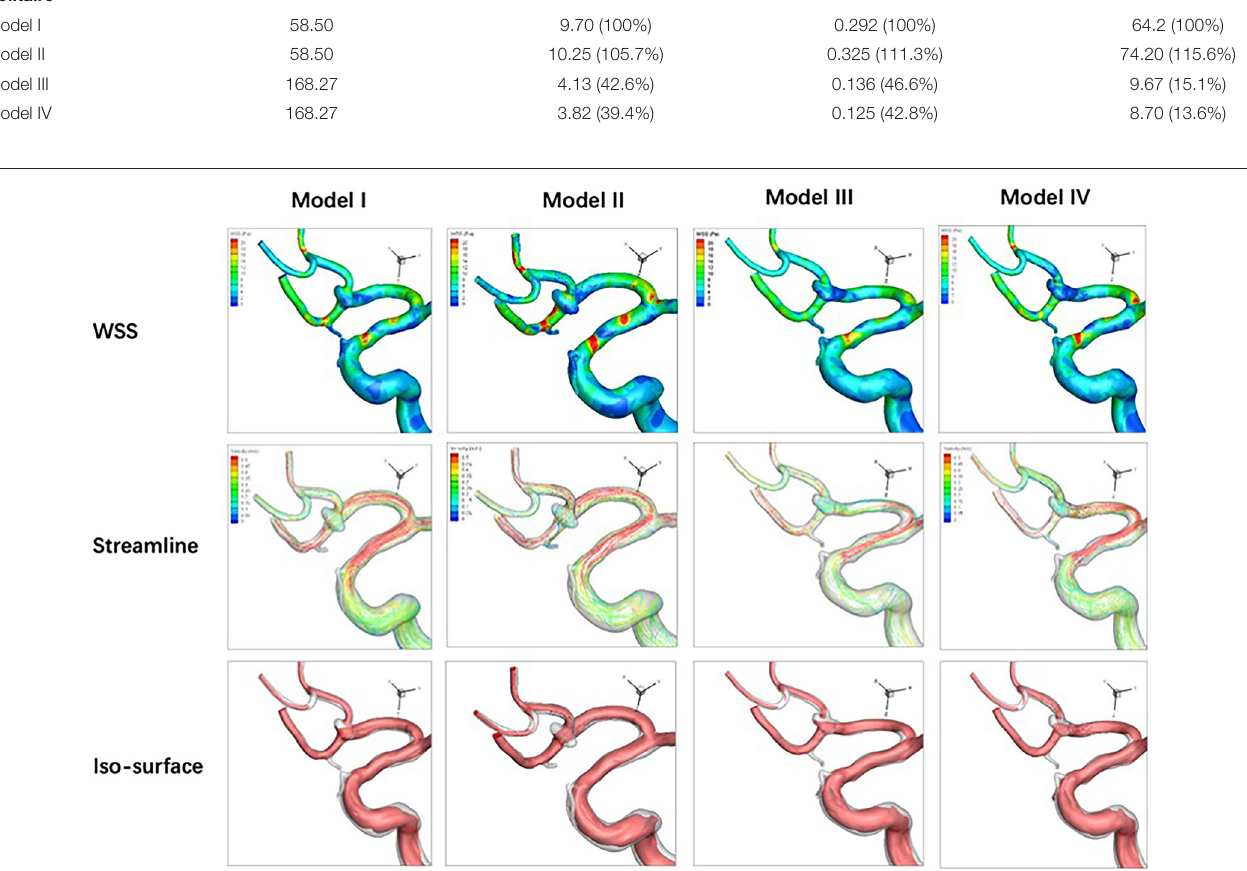
FIGURE 4 | For an anterior communicating artery aneurysm with Neuroform stenting, hemodynamic characteristics of four models are depicted. Wall shear stress, velocity, and high flow volume in Models III and IV decrease slightly compared with Models I and II.